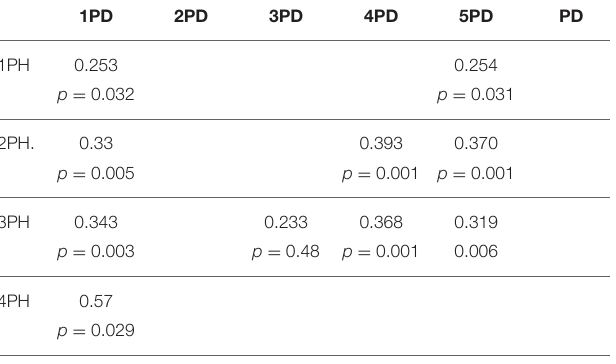
TABLE 5 | Correlation bettween hallucinations’ dimensions and delusions’ dimensions.